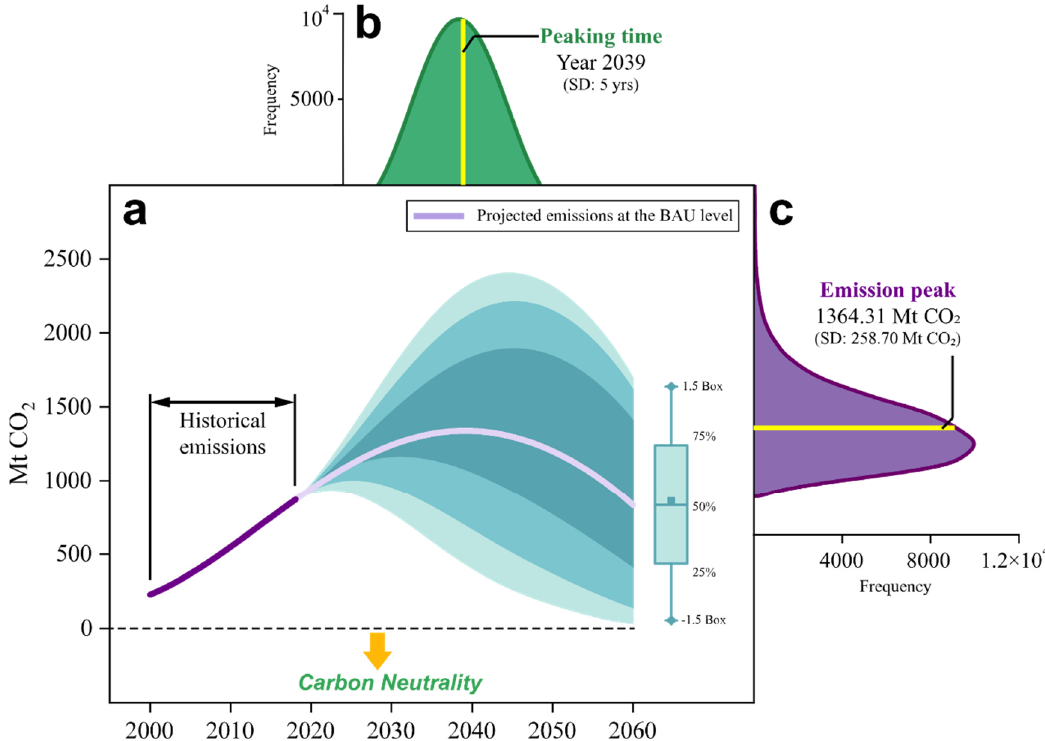
Figure 4. ( a ) Static emissions scenario with the emission peak dynamic scenario simulation towards 2060, and ( b , c ) the distribution of carbon peak status of the commercial building operations.